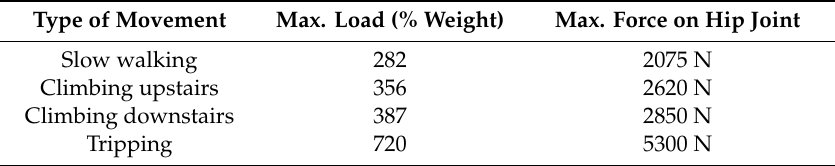
Table 4. Loading of hip implant for di ff erent types of movement.